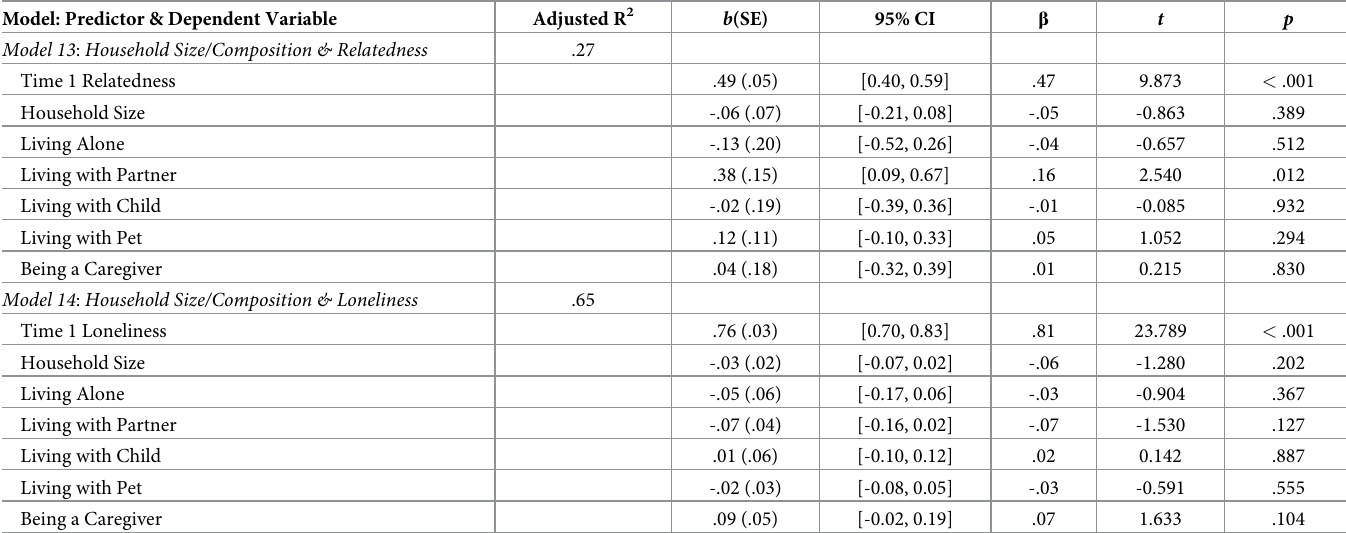
Table 7. Results of exploratory multiple regression models (Study